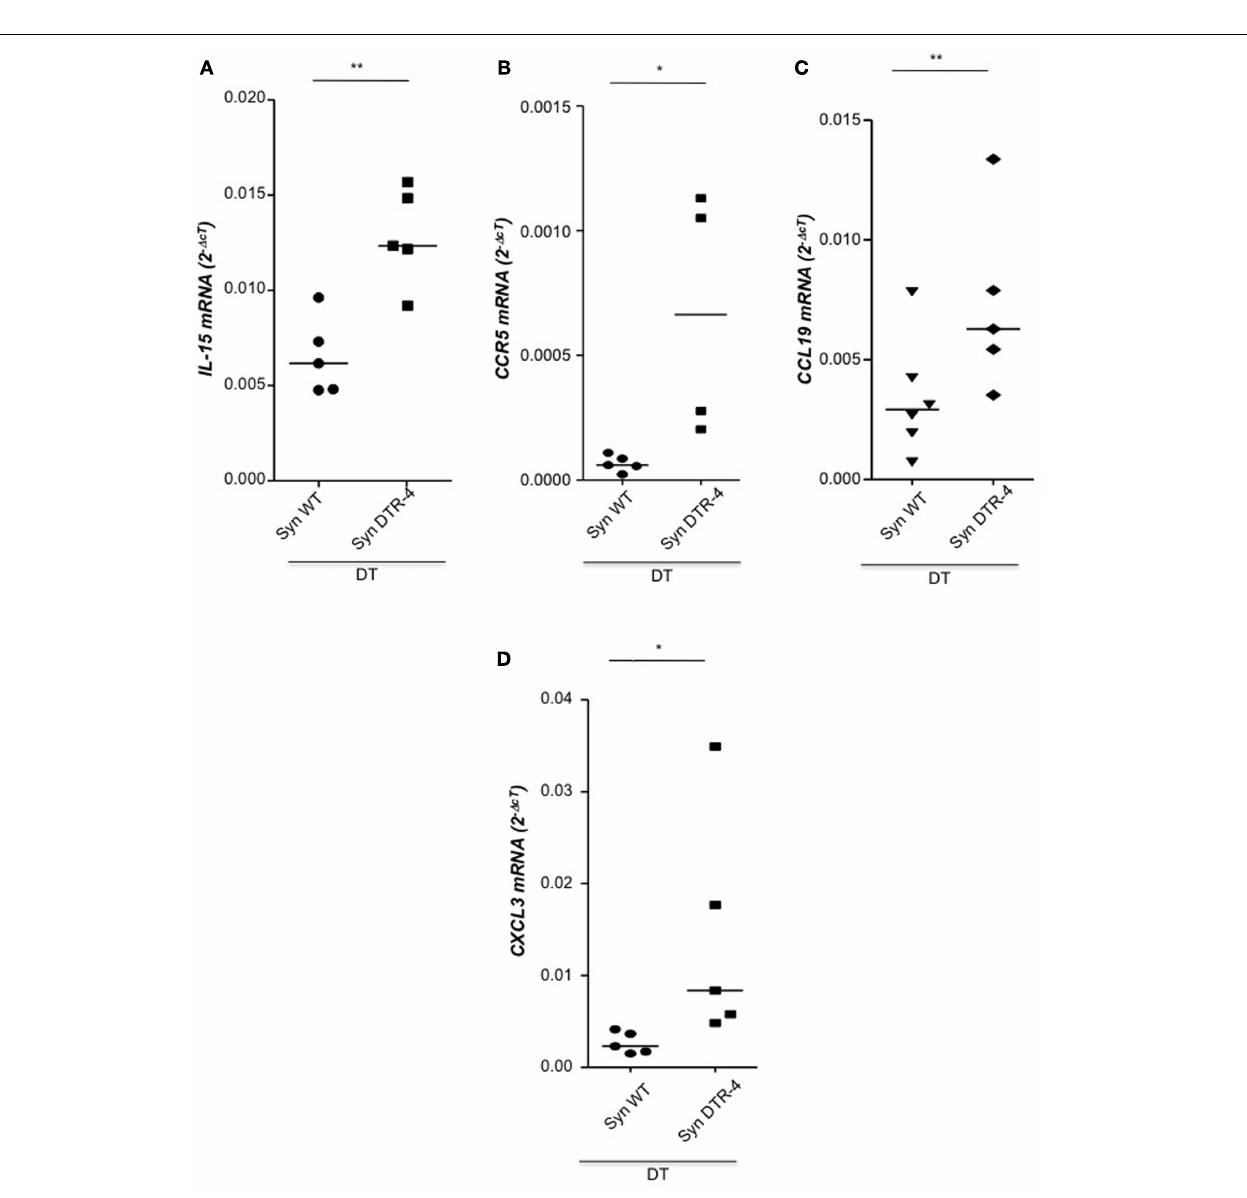
FIGURE 4 | Depletion of Tregs creates an inflammatory uterine milieu . In samples from Foxp3.LuciDTR-4 or wild type animals treated with DT by daily application starting on day 2 and further mated syngeneically, inflammation markers were measured ( n = 4–6/group) in uterine tissue by qPCR. Levels